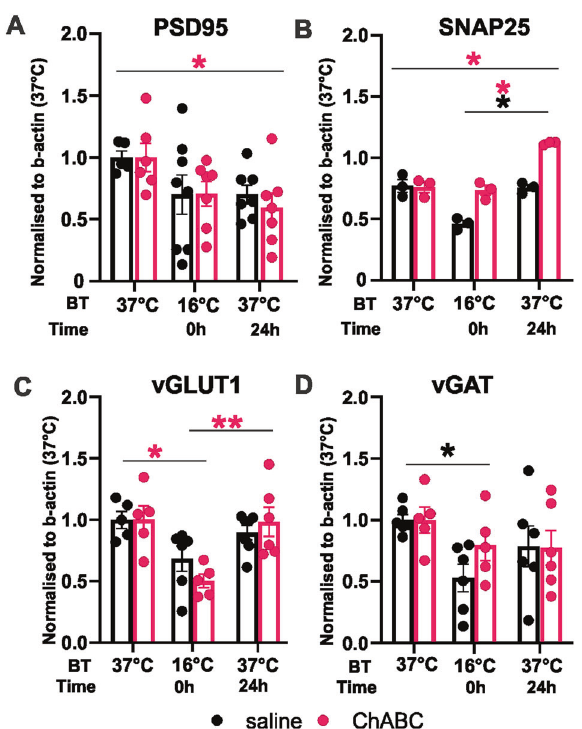
Fig. 3 Western blot analysis of pre- and postsynaptic markers from hippocampus lysate before, at the end of HLS and after 24 h recovery. The level of the presynaptic markers SNAP25, vGLUT1, vGAT dropped after HLS, then recovered after 24 h. The postsynaptic marker PSD95 showed no change, the recovery phase was not detected. ChABC treatment increased presynaptic SNAP25 particu- larly after rewarming (SNAP25, TW-ANOVA, Group F (1, 4) = 32.85 p = 0.0046). Western blot illustrative images in the supplements. Signi fi cance * p < 0.05, ** p < 0.01, *** p < 0.001 Statistics, Stat Table 3. Illustrative blot images in supplement. ( A , C , D n = 5 – 7 animals per group/time point; B n = 3 animals per group/time point). Statistical color coding: Between different time points the asterisk color coding indicates in which group the statistical signi fi cance was found. Within the single time points, the asterisk color coding indicates to which group the statistically signi fi cant difference was detected.